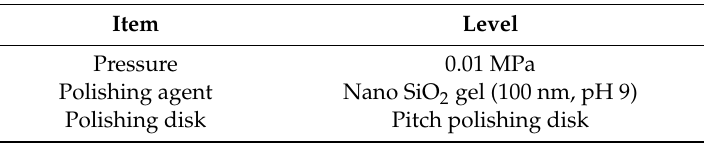
Table 5. Preceding-stage processing parameters (#1).